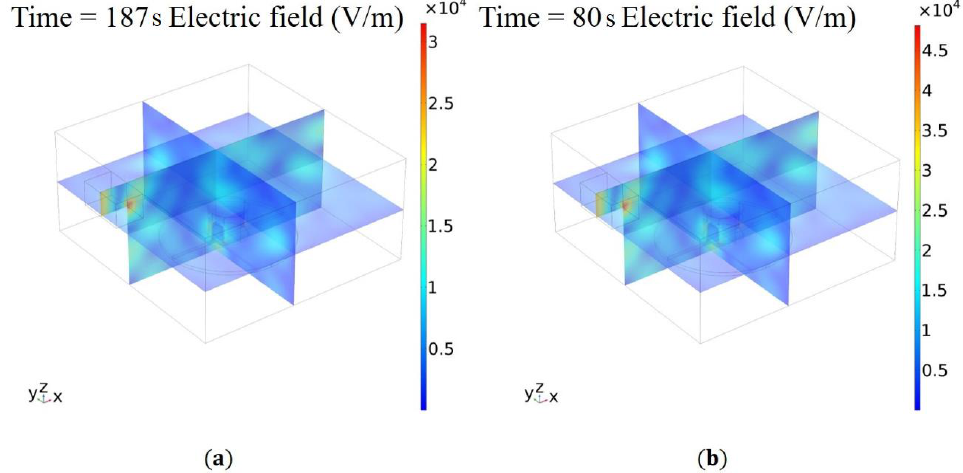
Figure 6. Electric field generated in the microwave chamber during the heating experiment of a water sample of 𝑣 = 100 cm 3 at 30% ( a ) and 70% ( b ) power